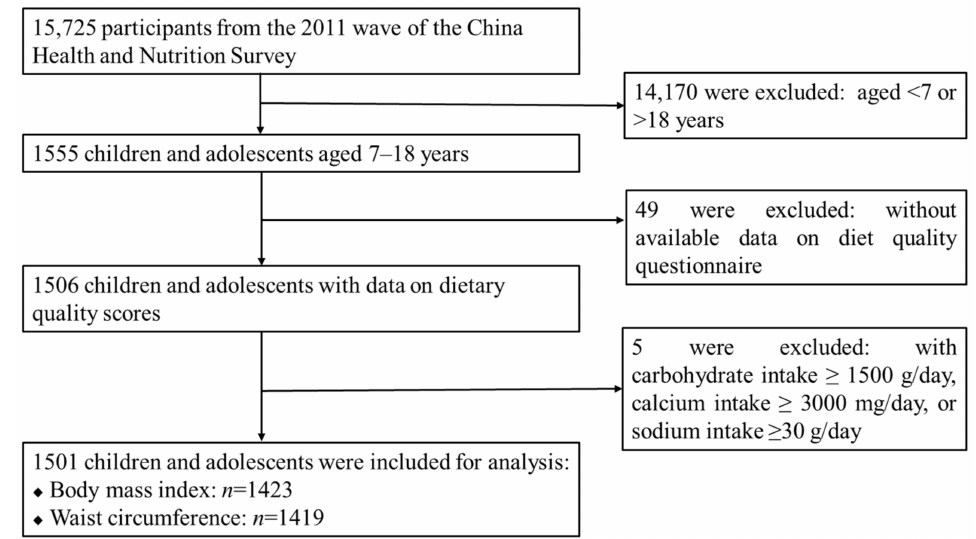
Figure 1. Flow chart of the inclusion/exclusion of